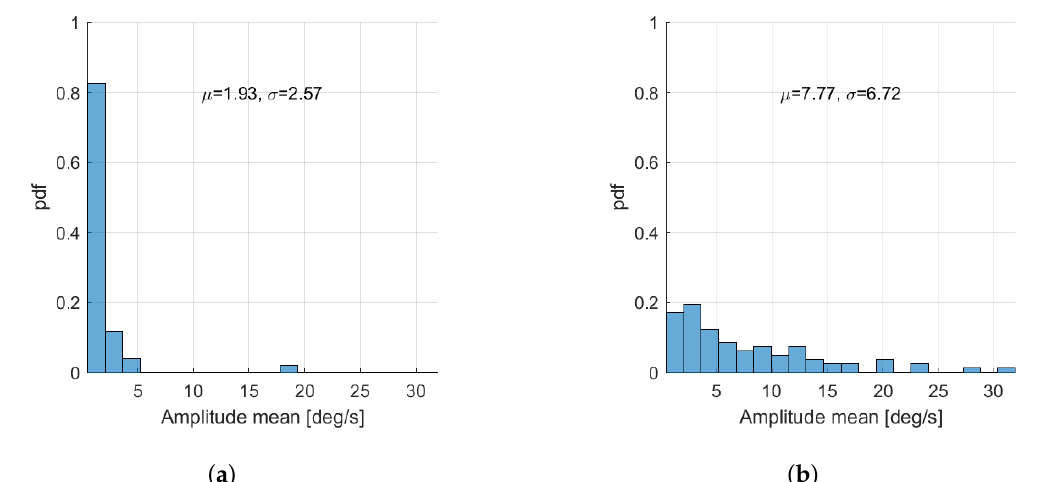
Figure 10. Distribution of the mean signal amplitude across the patients in A1 and B1 groups. ( a ) A1 group—patients without head tremor; ( b ) B1 group—patients with head tremor.